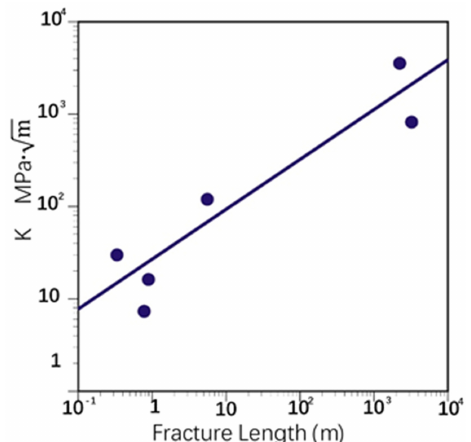
Figure 4. The relationship between the logarithmic median fracture length and the fracture toughness calculated using the field data on joints, veins, and dikes. Reprinted with permission from Ref. [107]. Copyright 2010, Elsevier.